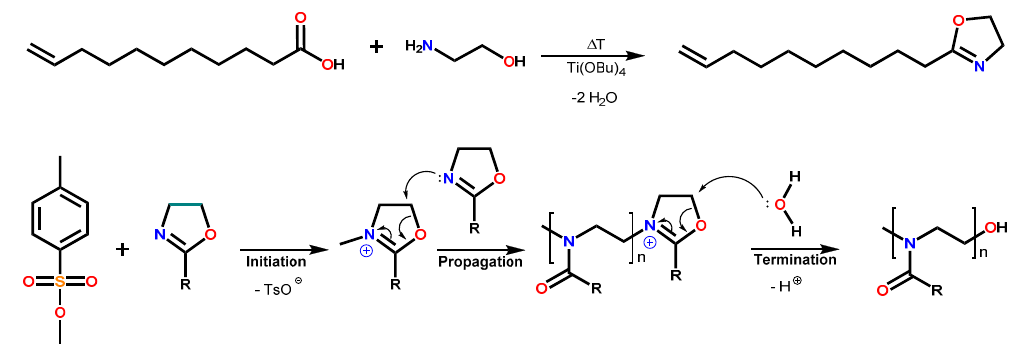
Scheme 1. Schematic representations of the synthesis of 2-oxazoline monomers from carboxylic acids ( top ) and the cationic ring-opening polymerization of 2-oxazolines ( bottom ).